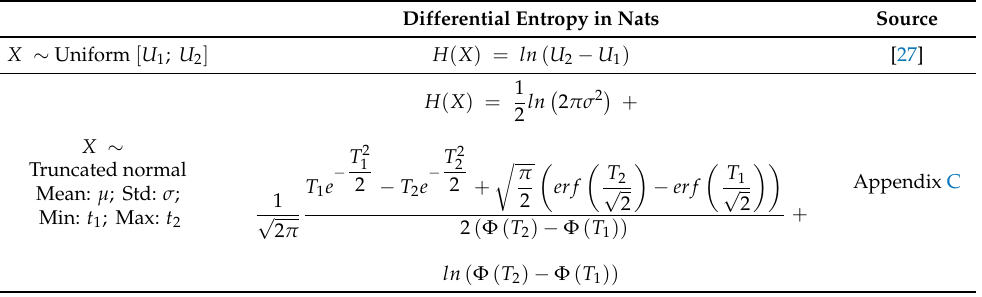
Table 7. Differential entropy of uniform and truncated normal